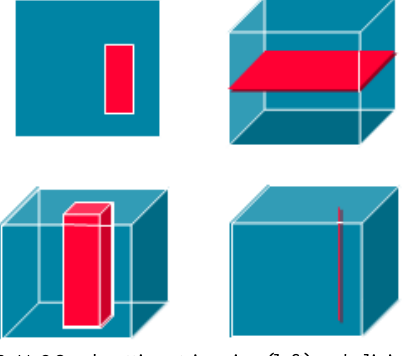
Figure 3. WCS subsetting: trimming (left) and slicing